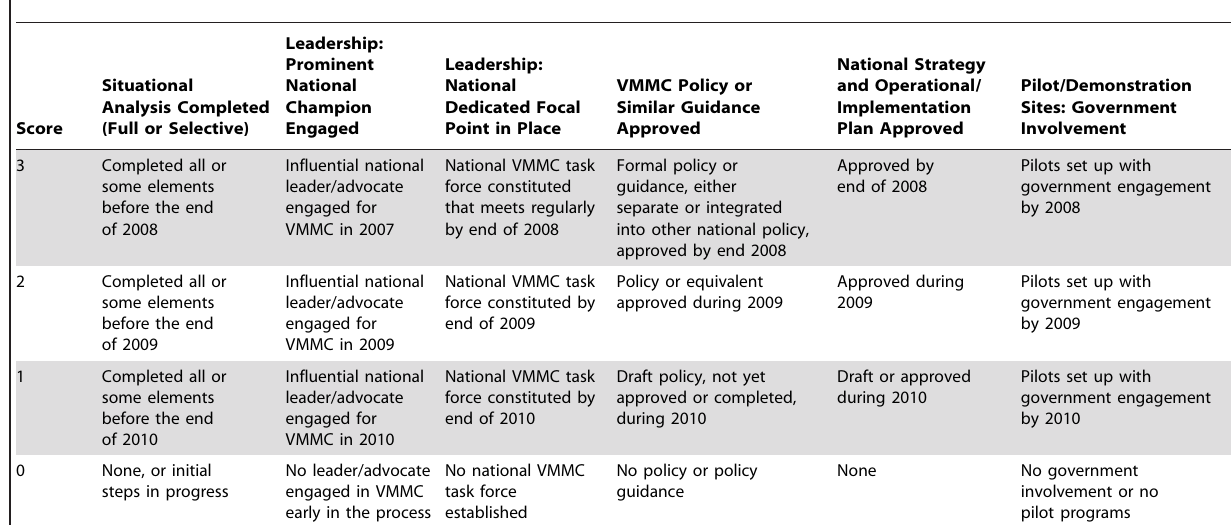
Table 3. VMMC key elements of program scale-up scoring key.